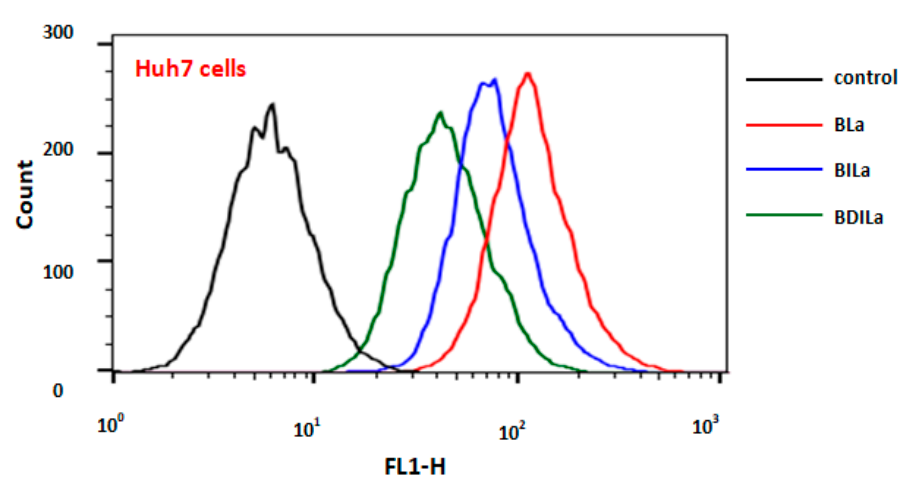
Figure 5. The fluorescence-activated cell sorting (FACS) analysis of the BODIPY dyes BLa, BILa, and BDILa in Huh7 cells.